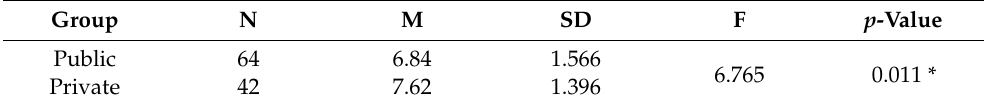
Table 3. ANOVA test of post-test data and type of